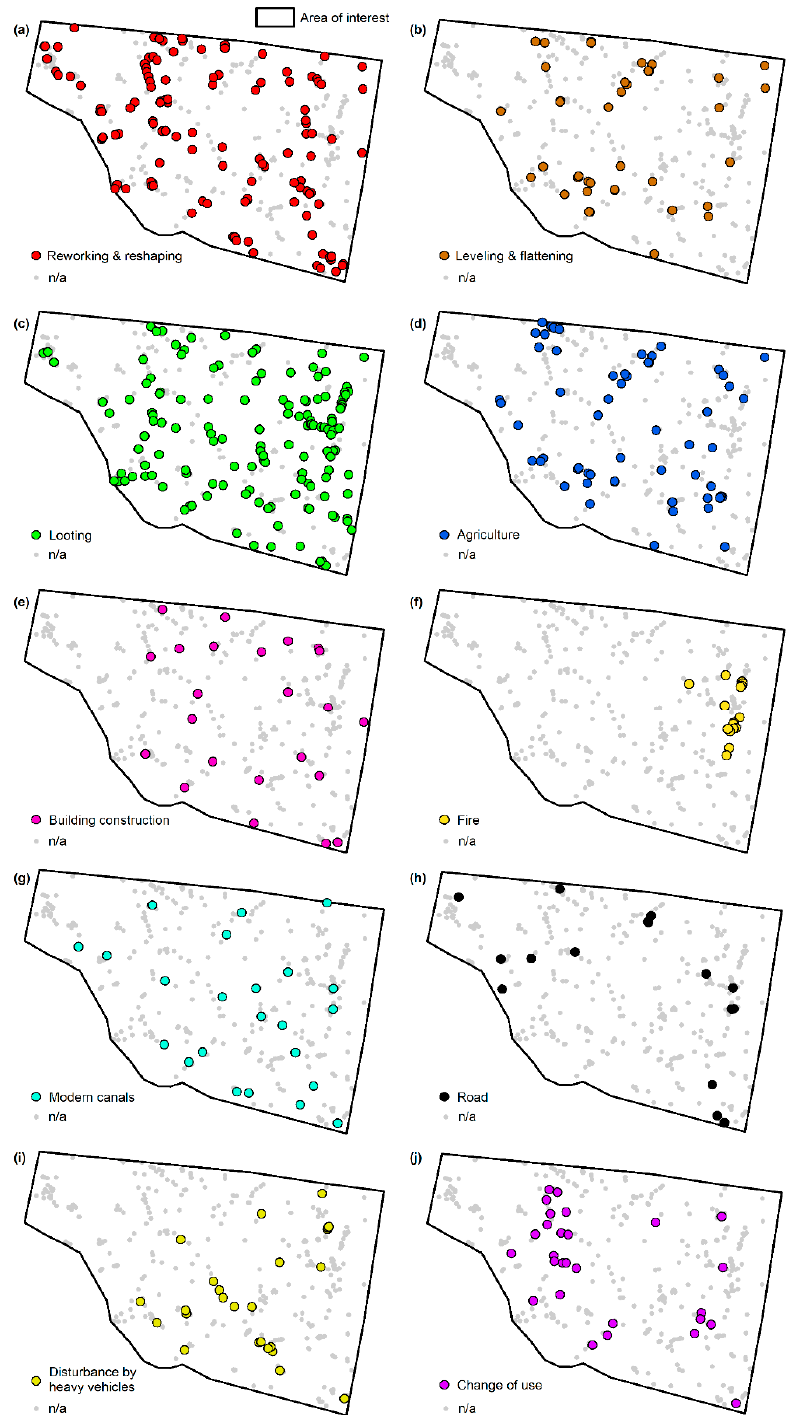
Figure 11. Spatial distribution of the mapped tells by the mostly impacting threats due to anthropogenic actions: ( a ) reworking and reshaping, ( b ) leveling and flattening, ( c ) looting, ( d ) agriculture, ( e ) building construction, ( f ) fire, ( g ) modern canals, ( h ) road, ( i ) disturbance by heavy vehicles, and ( j ) change of use.